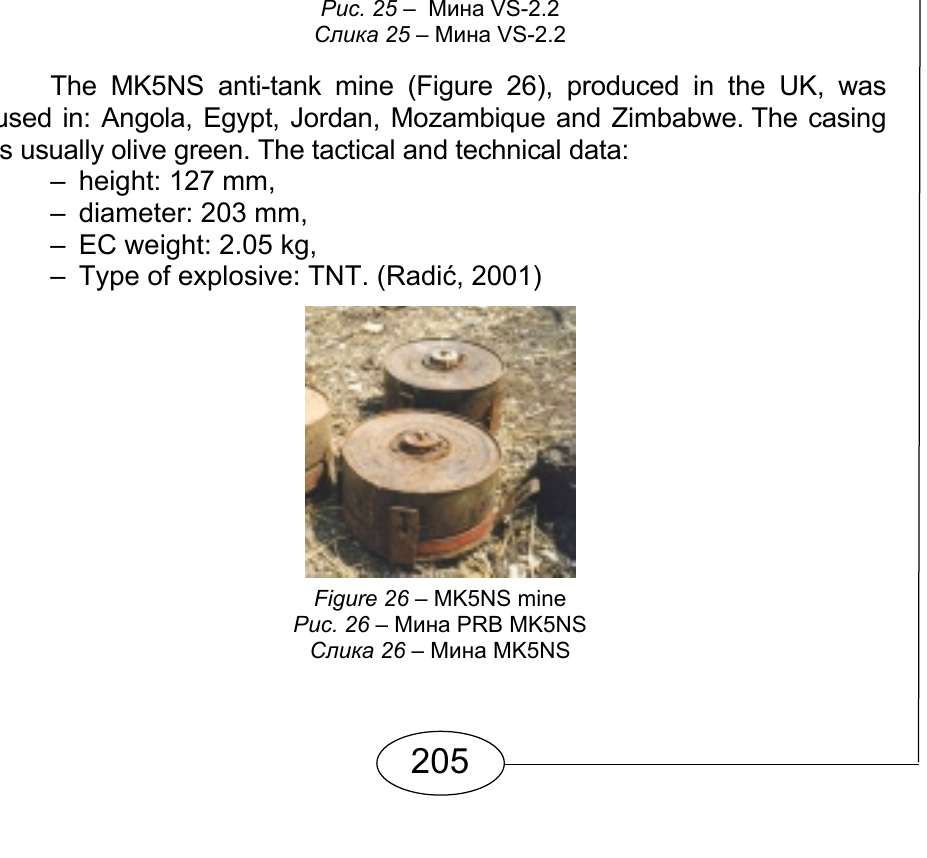
Figure 25 – VS-2.2 mine Рис . 25 – Мина VS-2.2 Слика 25 – Мина VS-2.2